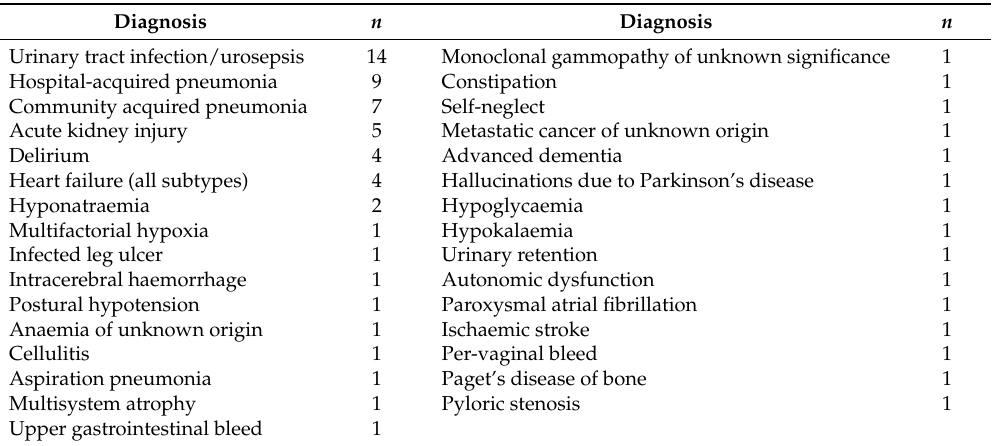
Table 2. Medical discharge diagnoses of patients with a suspected occult hip fracture subsequently proven to not have a hip fracture. proven to not have a hip